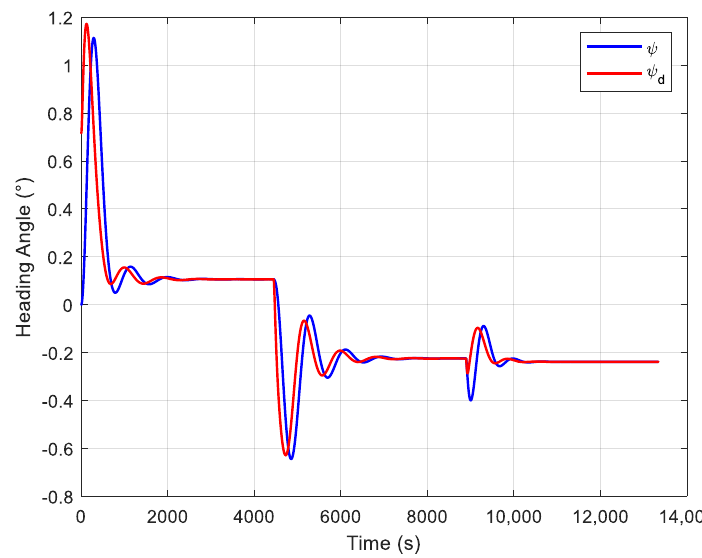
Figure 6. The desired heading angle vs. the true heading angle in the proposed guidance law at